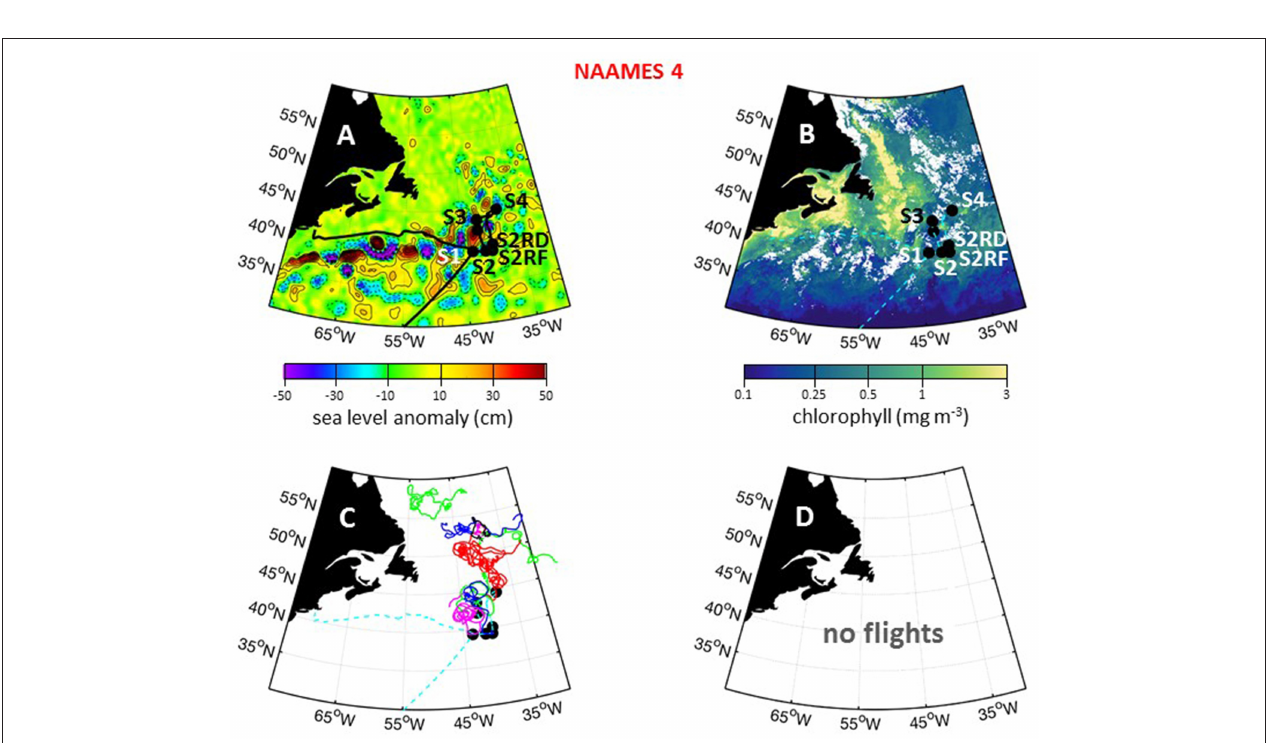
FIGURE 15 | NAAMES 4 primary stations, autonomous floats, and flight tracks. (A) Black line = ship transit. Labeled black circles = primary sampling stations. Background color = sea surface height anomalies highlighting anticyclonic and cyclonic mesoscale eddies in red and blue/purple, respectively. (B) Climatological surface chlorophyll concentrations for the NAAMES 4 period from satellite ocean color measurements. (C) One hundred and thirty day trajectories for previously deployed floats that were still active during NAAMES 4. No new floats were deployed during NAAMES 4. Star = float deployment site. (D) No C-130 flights were conducted during NAAMES 4 due to mechanical issues with the aircraft. Broken cyan line in (B–D) = ship track.